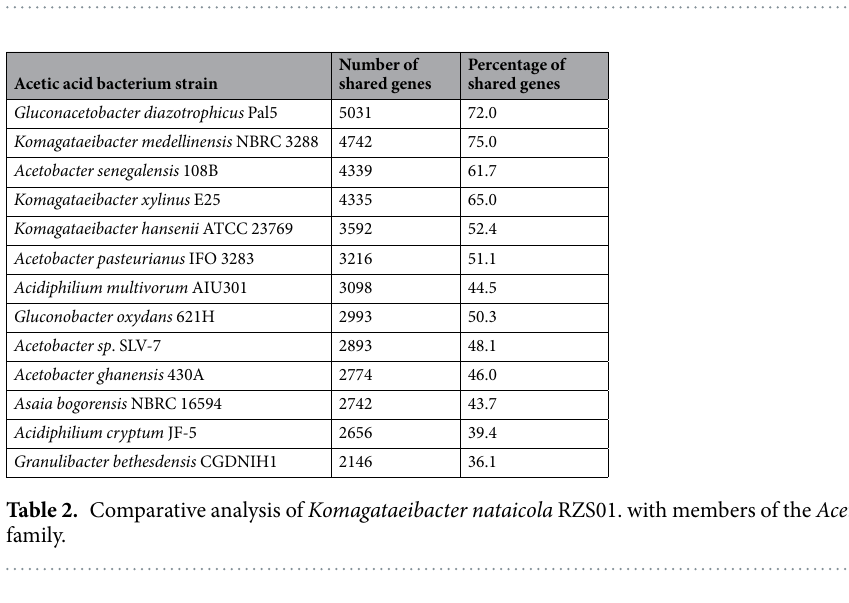
Percentage of shared genes